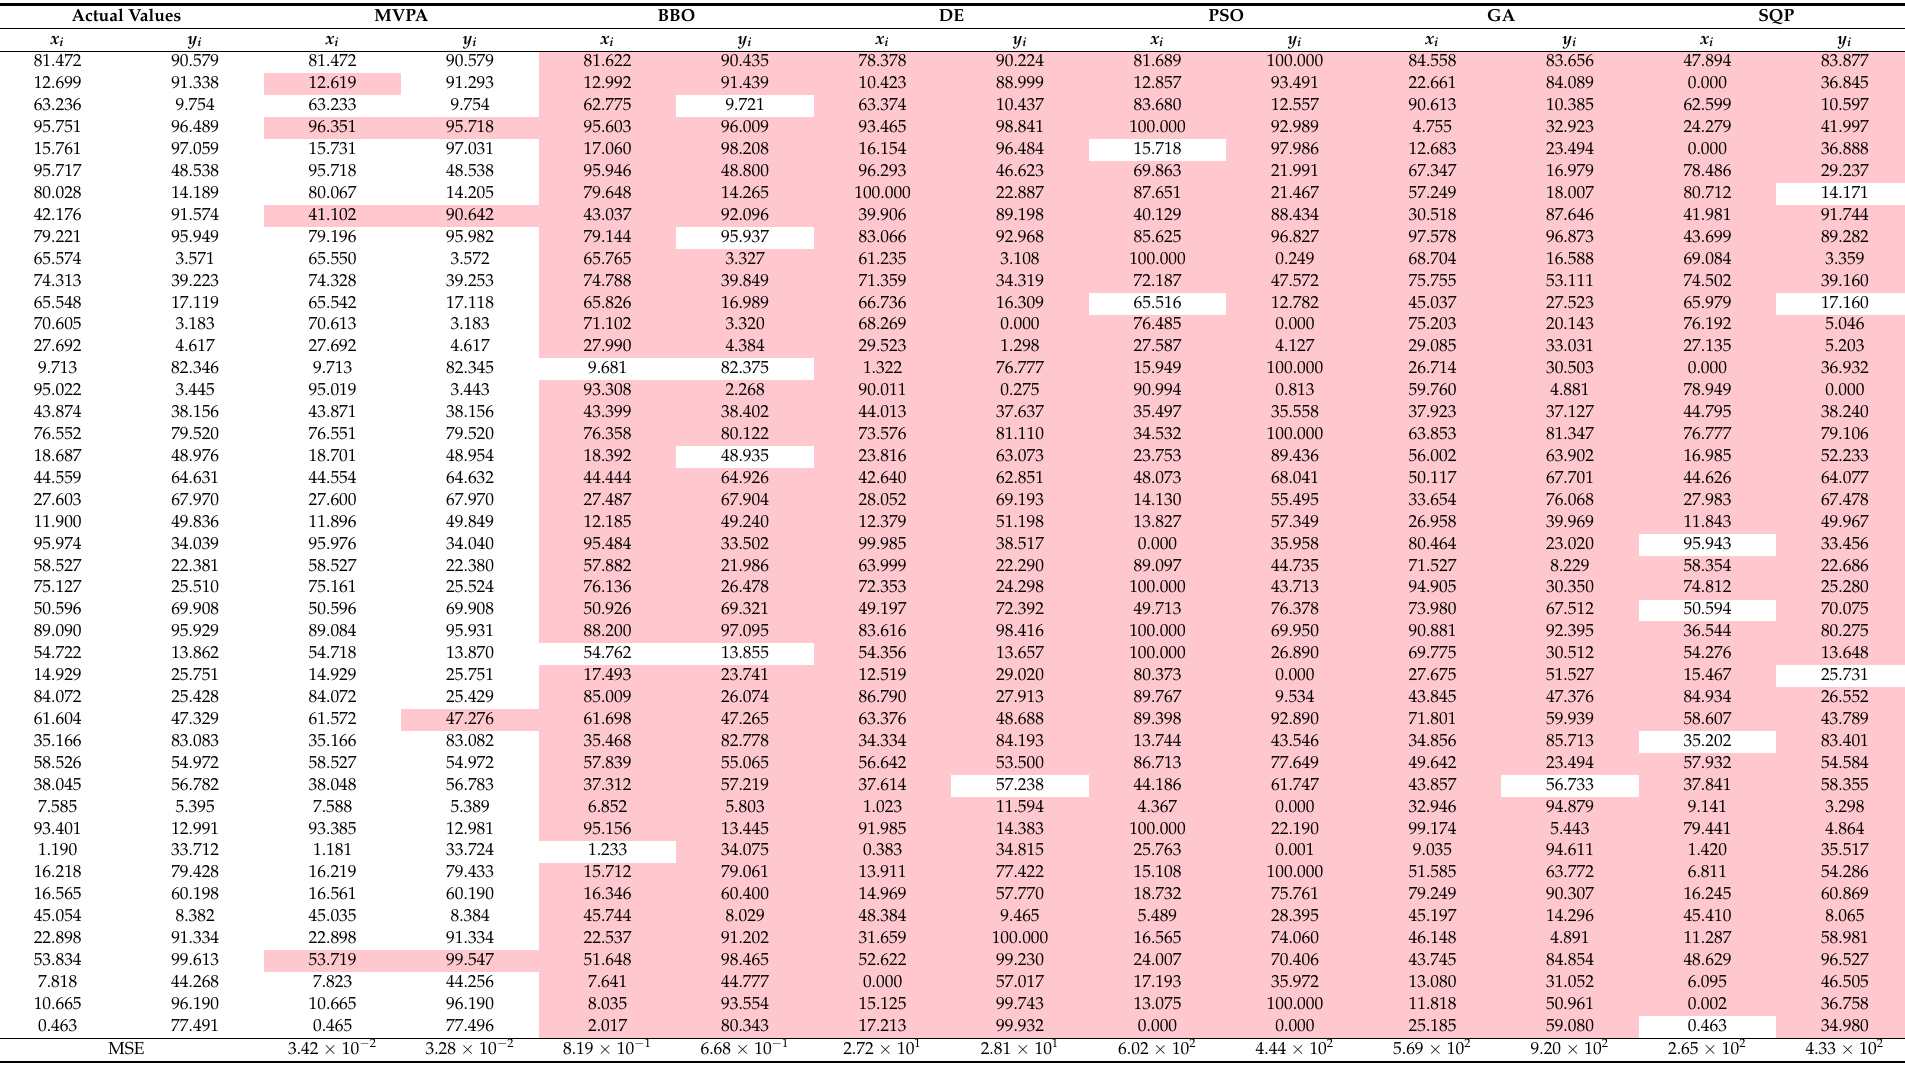
Table 4. Comparison of actual locations with those obtained using different algorithms for case